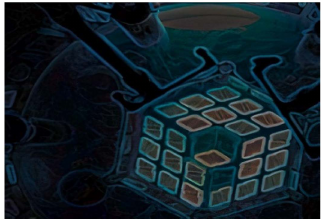
Figure 2. Artistic rendering of the MITR reactor core [14].